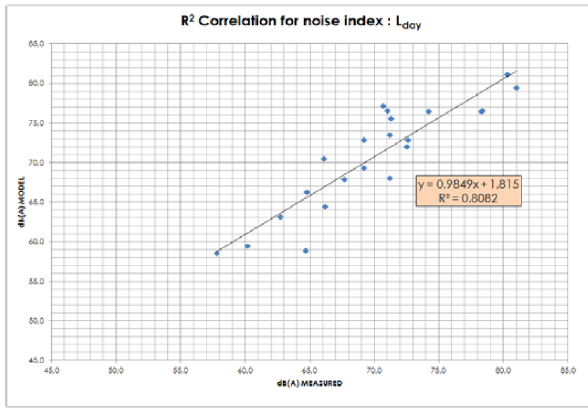
Figure 3: R 2 Correlation for noise index: L